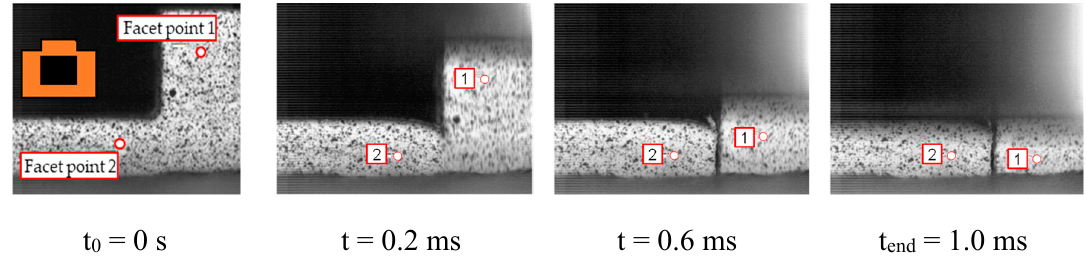
Figure 6. Image sequence for DIC taken during a shear test. Table 2. Calculated and measured parameter values for the setup with a pneumatically driven hammer.